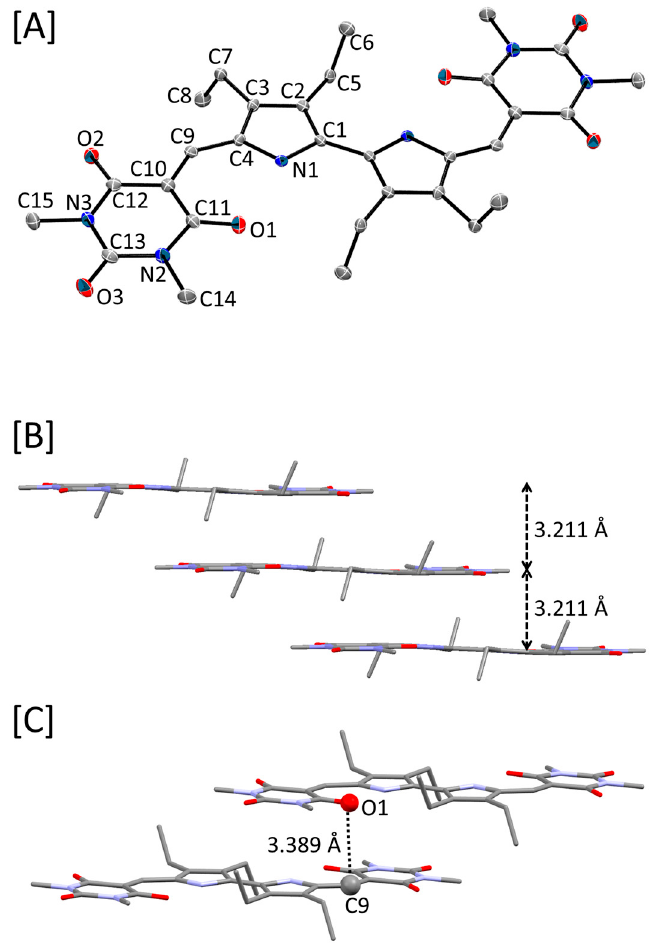
Figure 3. ( A ) The ORTEP diagrams of compound 4 with the atomic labeling; ( B ) side view with the interlayer distances; ( C ) closest interatomic distance in a pair of 4 . Hydrogen atoms were omitted for clarity. The thermal ellipsoids were drawn at 50% probability level.